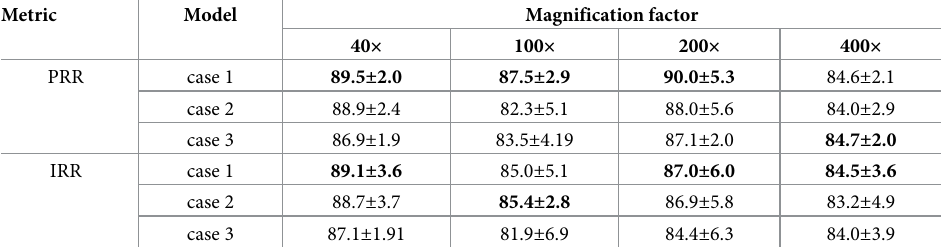
Table 3. Performance of BC classification by the different network combinations: Case1) the complete IDSNet based on DenseNet interleaved with SENet and classification sub-network; Case2) the DenseNet combined with classification sub-network only; Case3) DenseNet combined with SENet module only. The best performance is highlighted by boldface.